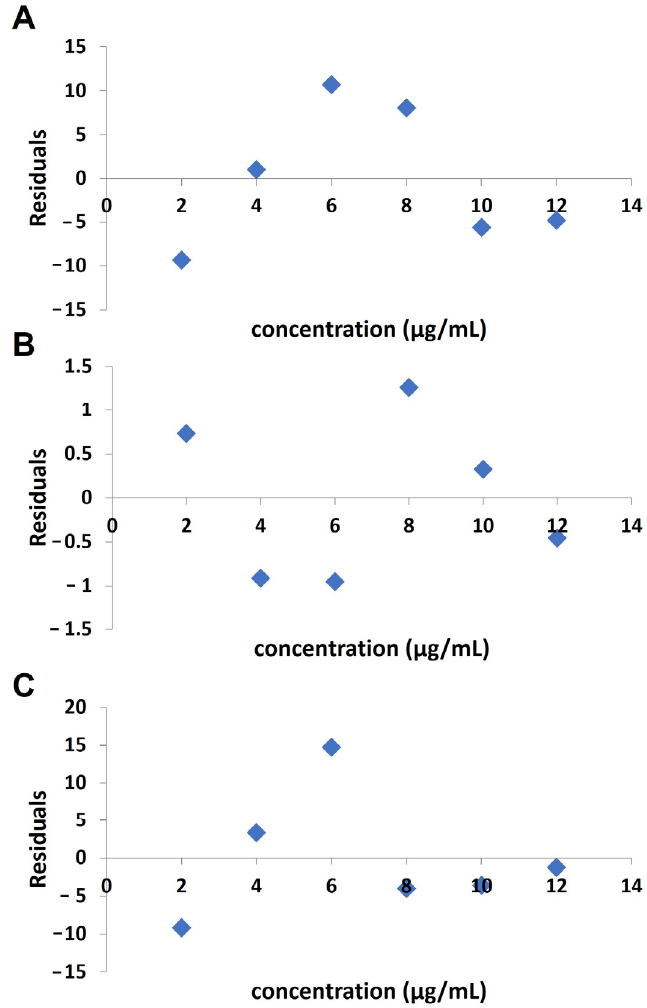
Figure 7. Residual plots of calibration curves for andrographolide (AND) ( A ), neoandographolide (NAND) ( B ), and 14-deoxy-11,12-didehydroandrographolide (DAND) ( C ). Table 3. Method calibration data. Table 4. Precision and accuracy